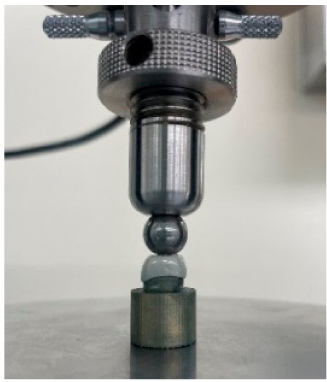
Figure 2. Die–crown unit positioned in the universal testing